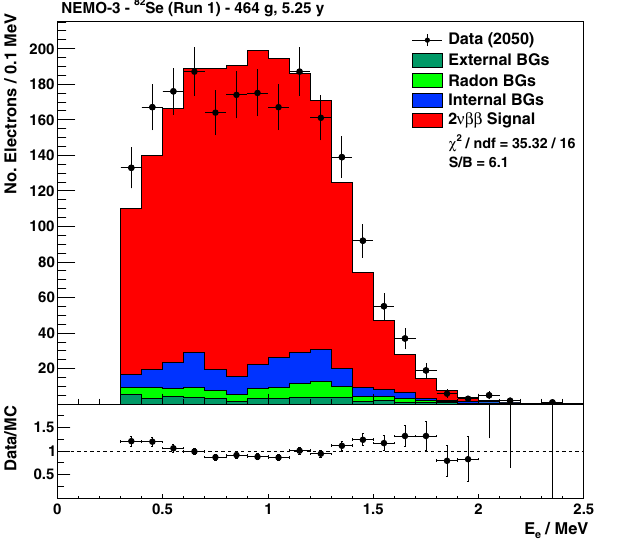
HSD and SSD hypotheses. There is good agreement between the data and SSD hypothesis ( χ 2 / ndf = 12 . 3 / 16), but the HSD hypothesis is disfavoured ( χ 2 / ndf = 35 . 3 /